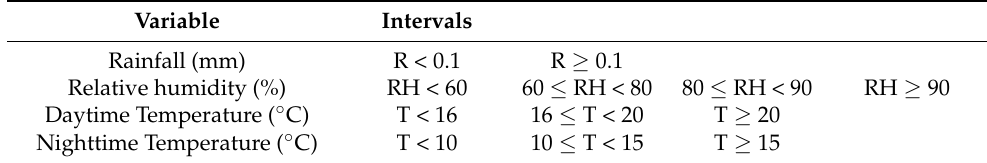
Table 2. Intervals of rainfall (R), relative humidity (RH) and air temperature (T) considered with hourly data in the frequency analysis. A class of weather variables is a combination of defined intervals of R, RH and daytime (7.00 a.m. to 8.59 p.m.) and nighttime (9.00 p.m. to 6.59 a.m. the following day) T. All times were local (GMT + 2 in